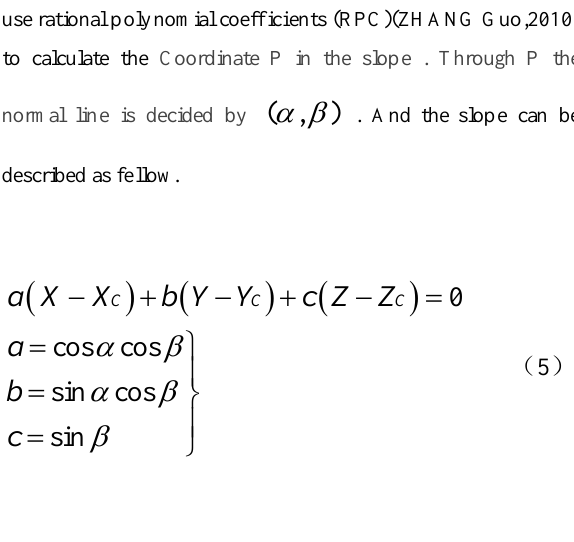
Figure 4. geometrical constraint of projection model figure 4 shows the projection relationship of the Region-Based least squares matching. In figure 2, 0 p is the added point we